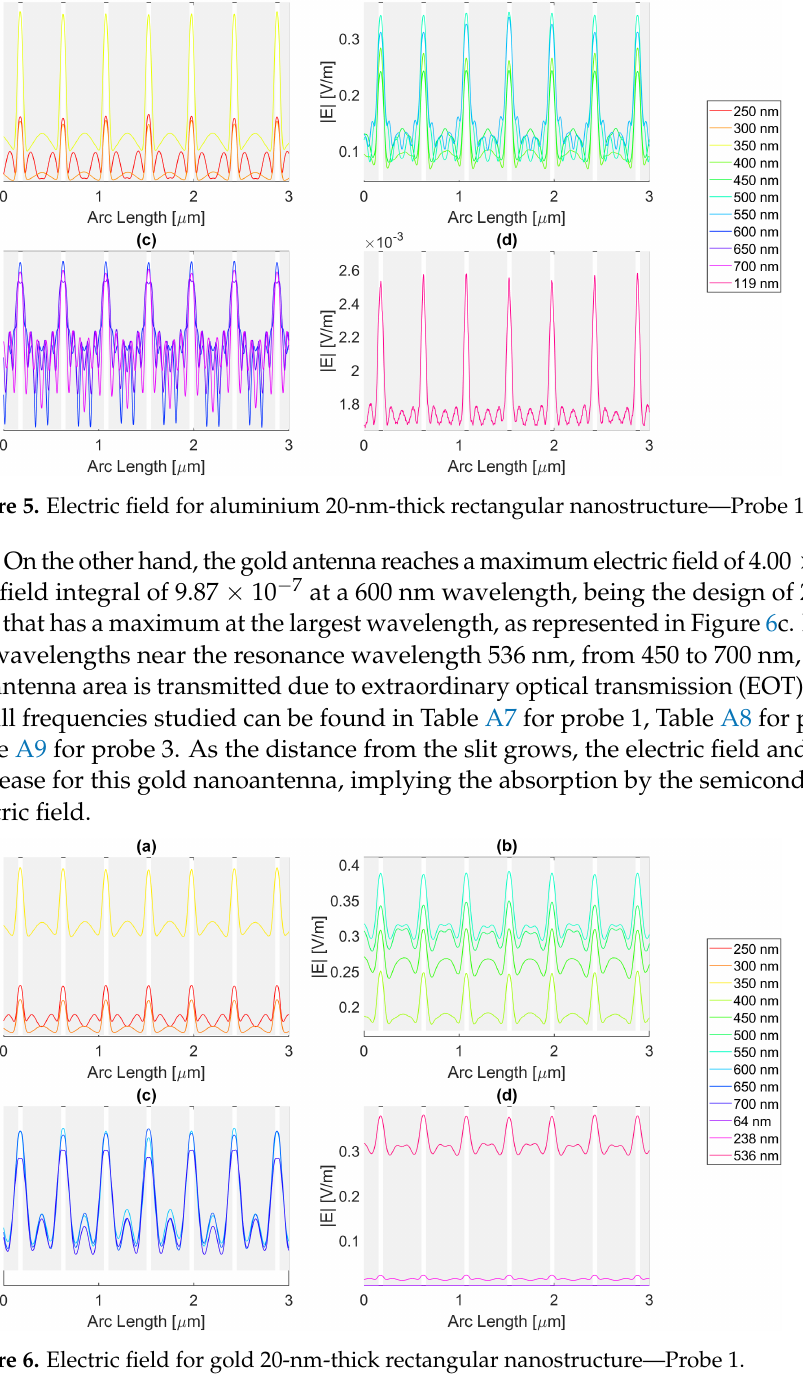
Figure 6. Electric field for gold 20-nm-thick rectangular nanostructure—Probe